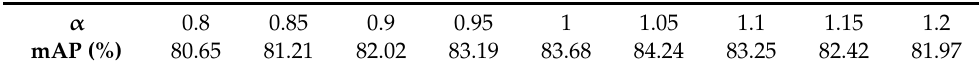
Table 4. AP of each defect category.